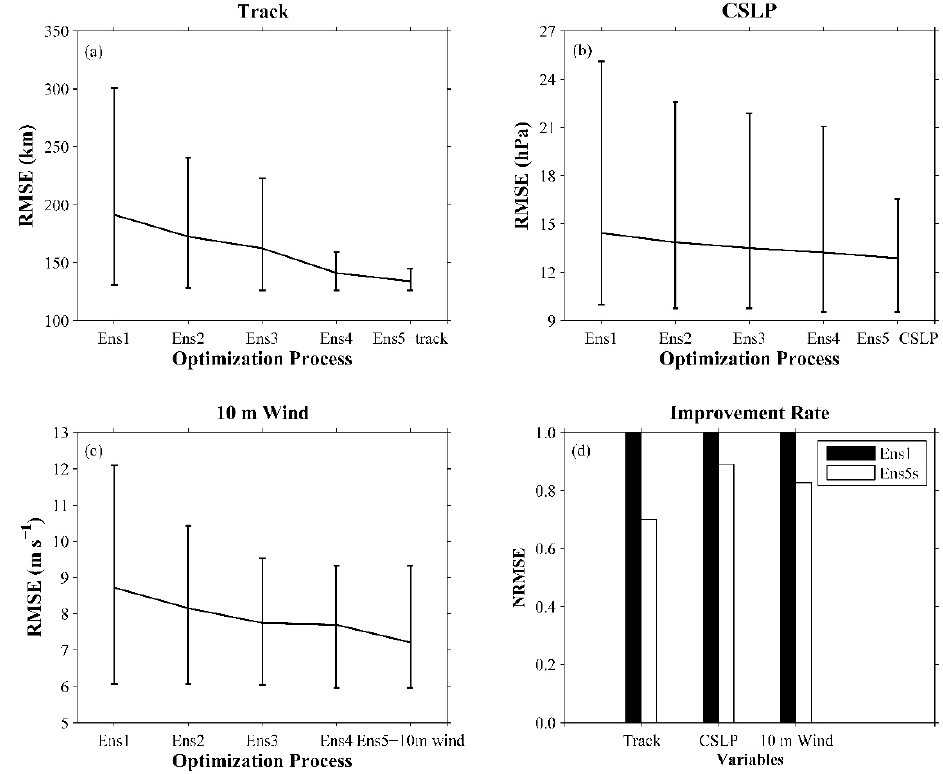
Figure 4. Optimization speed and e ffi ciency for the 15 typhoon simulations of track, CSLP, and 10-m wind. Ens1, Ens2, Ens3, and Ens4 represent the four ensembles. Ens5-track, Ens5-CSLP, and Ens5-10m wind represent the optimal ensemble of track, CSLP, and 10-m wind, respectively. ( a – c ) represent optimization speeds of the track, CSLP, and 10 m wind simulations, respectively. ( d ) represents the improvement rate of Ens5s for typhoon simulation compared to Ens1.